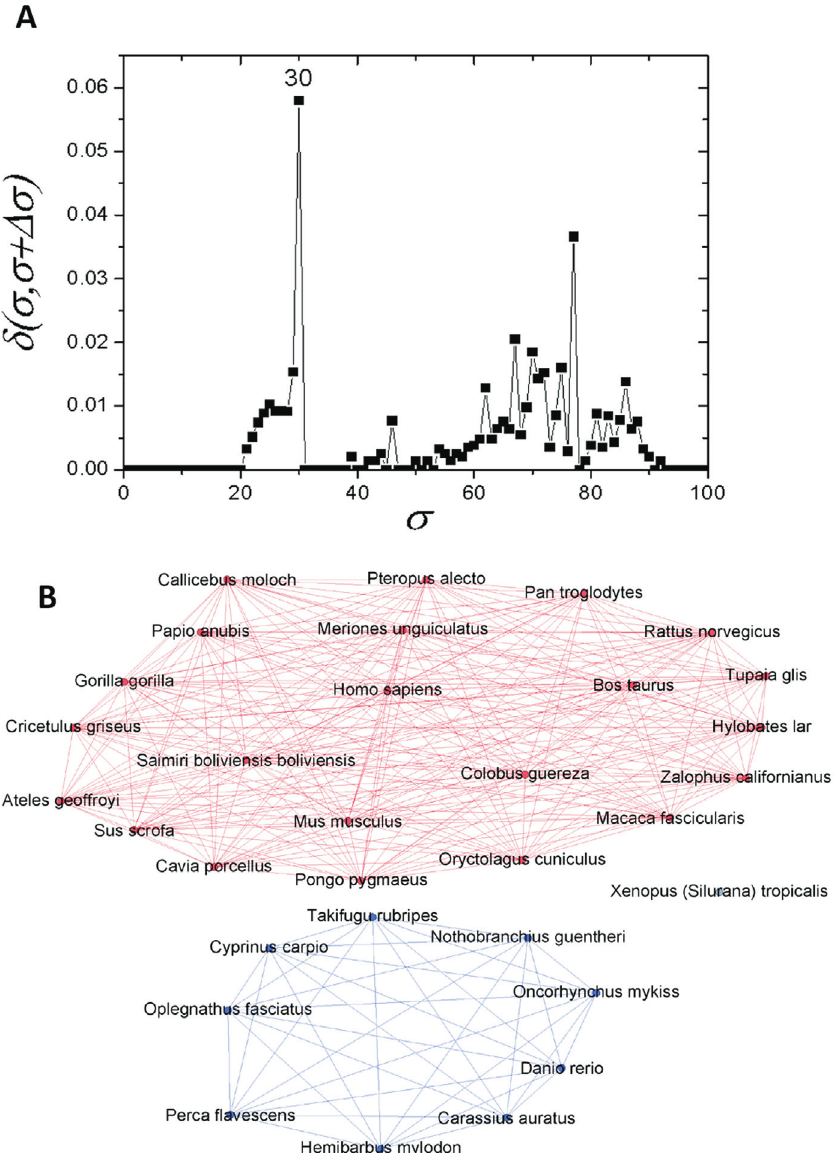
Figure 3 - Complex networks analysis. (A) Graph showing the (cid:5) -distance between the networks, emphasizing the indication of the branching event at (cid:3) cst =30% . Smaller peaks related to branching events in primate and fish sub-communities are highlighted in Figures 5A and 6A. (B) Representation of apo E network at (cid:3) cst =30%